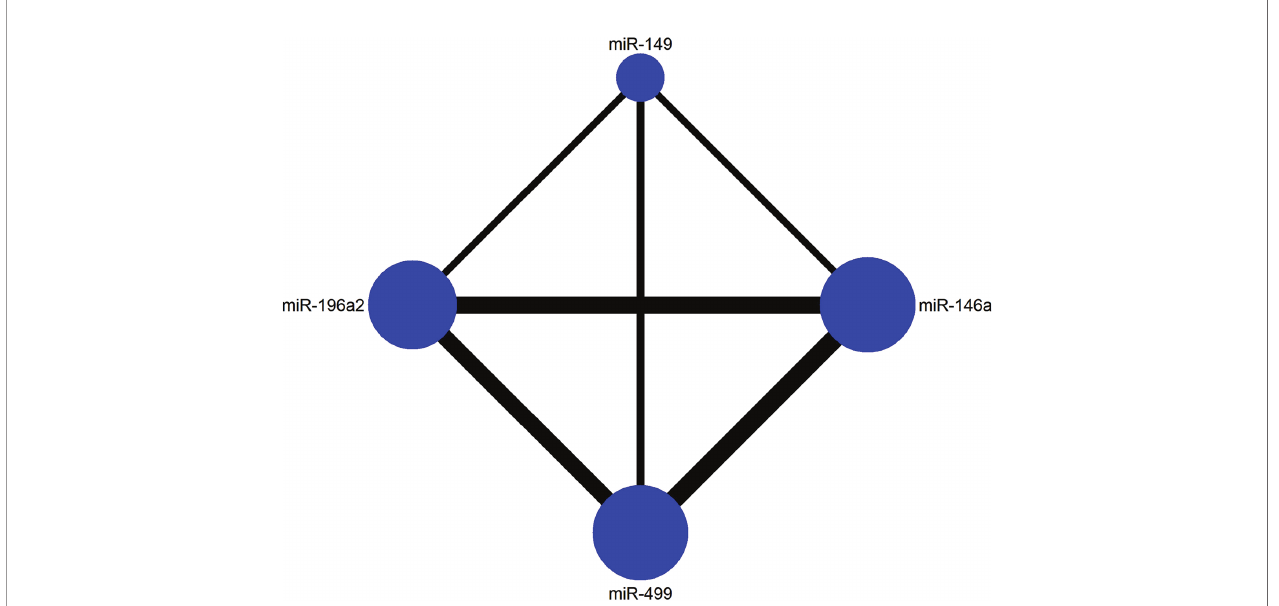
FIGURE 6 | The network evidence plot of four single nucleotide polymorphisms (SNPs).